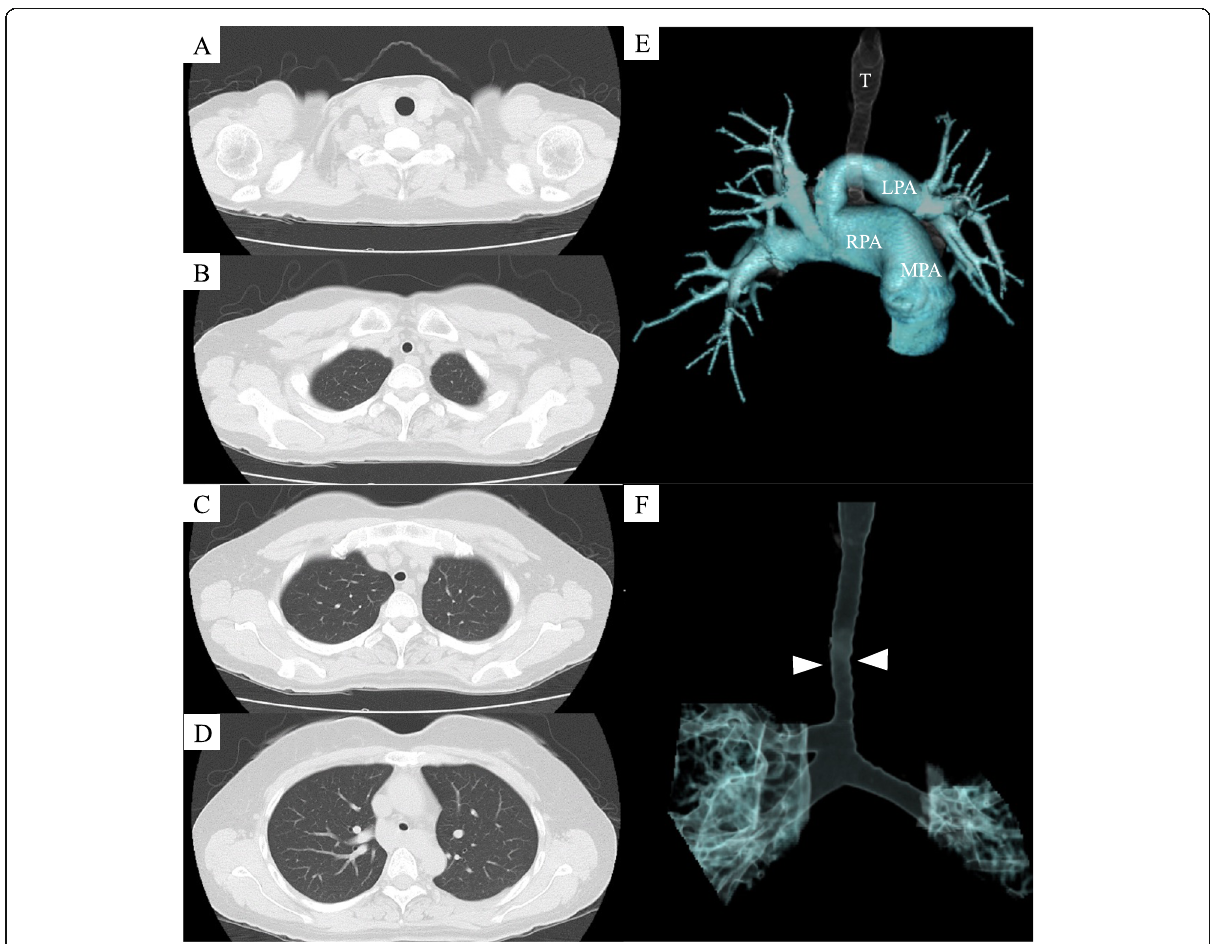
Fig. 1 Preoperative imaging findings. Chest computed tomography showed stenosis over the entire length of the trachea with complete tracheal rings ( A - D ). Reconstructed three-dimensional images showed a pulmonary artery sling ( E ) and tracheal bronchus ( F ). The narrowest part of the trachea (arrowheads) was 6 mm in diameter ( F ). The left pulmonary artery originated from the right pulmonary artery and encircled the trachea ( E ). MPA, main pulmonary artery; RPA, right pulmonary artery; LPA, left pulmonary artery; T,